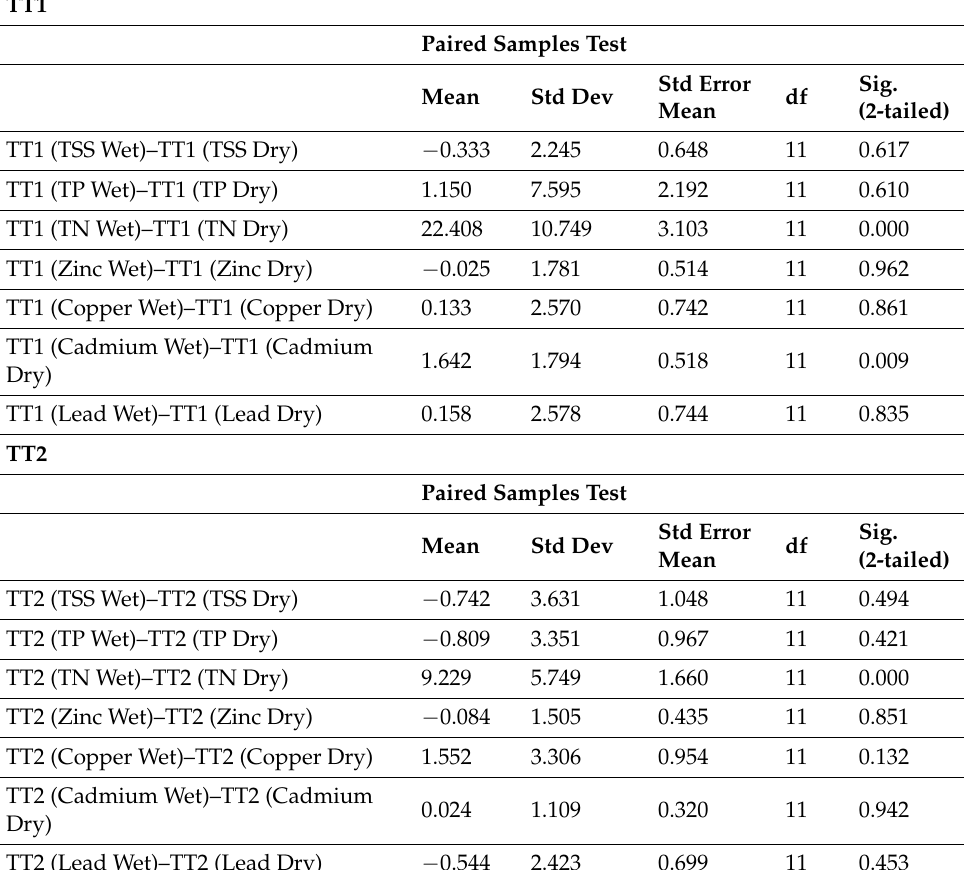
Table A7. Paired sample test for Phase 2 of